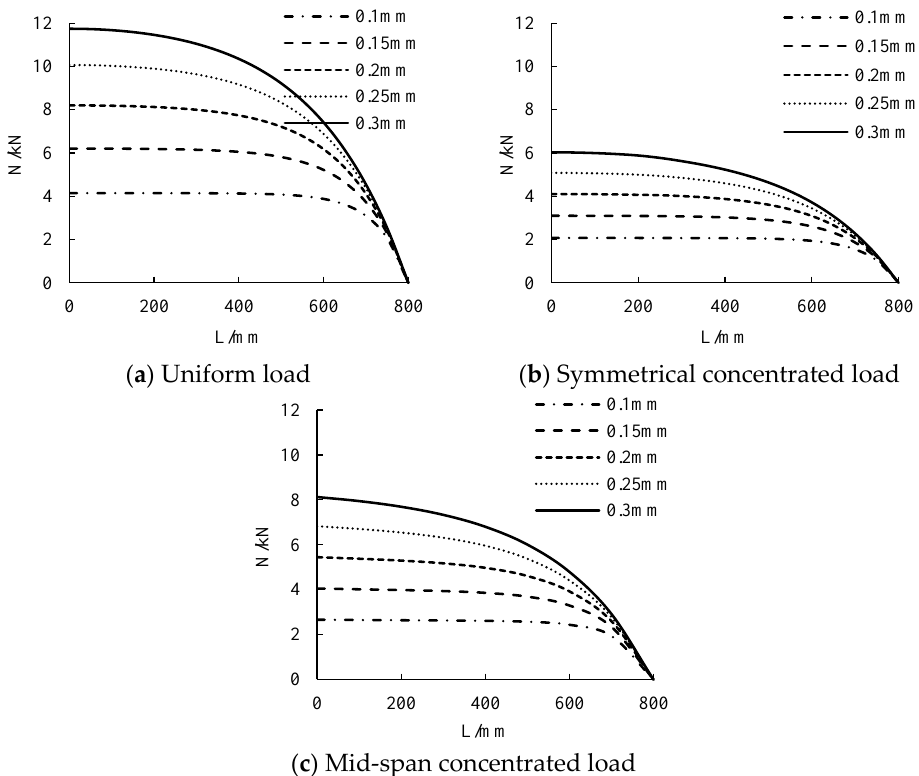
Figure 10. The influence of CFRP sheet’s thickness on tensile force.